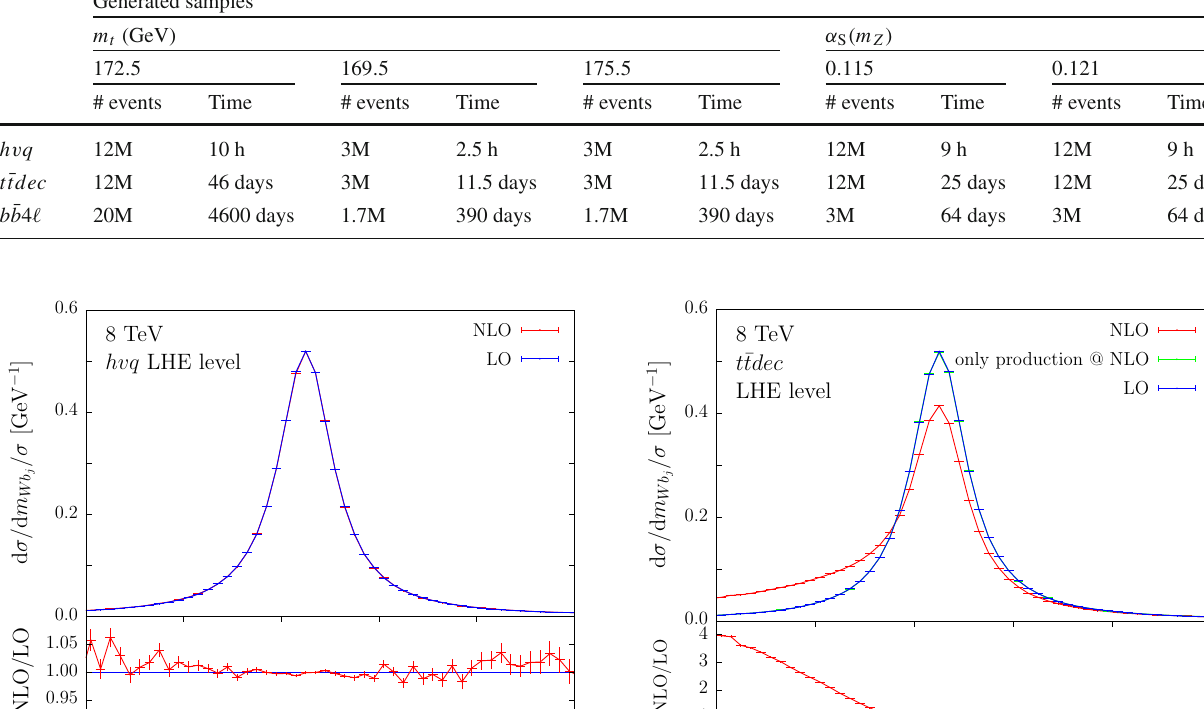
This leads to a difference that can be sizeable, depending upon the complexity of the virtual corrections